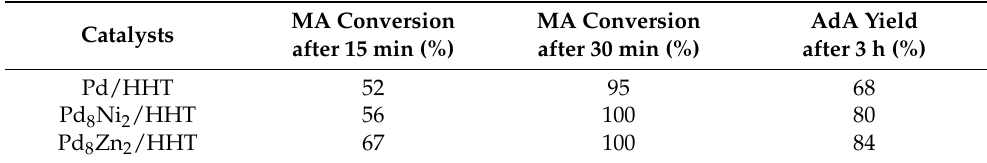
Table 1. Summary of the catalytic results. Reaction conditions: MA concentration 0.1 M, temperature 70 ◦ C, 2 bar pressure of H 2 , metal/substrate ratio 1/500.